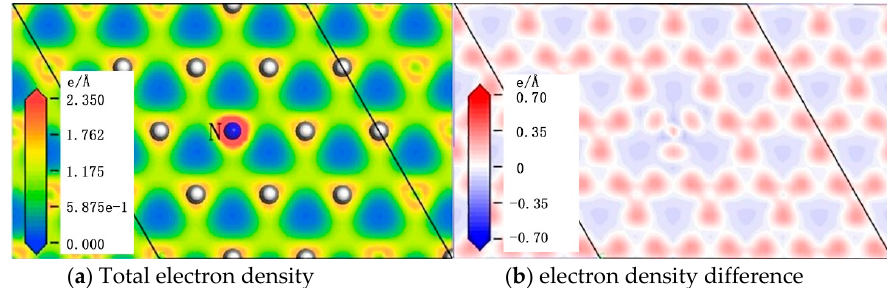
Figure 3. Contours of total electron density and electron density di ff erence on 2D slices through carbon atom and substituted B, Si and N atoms.